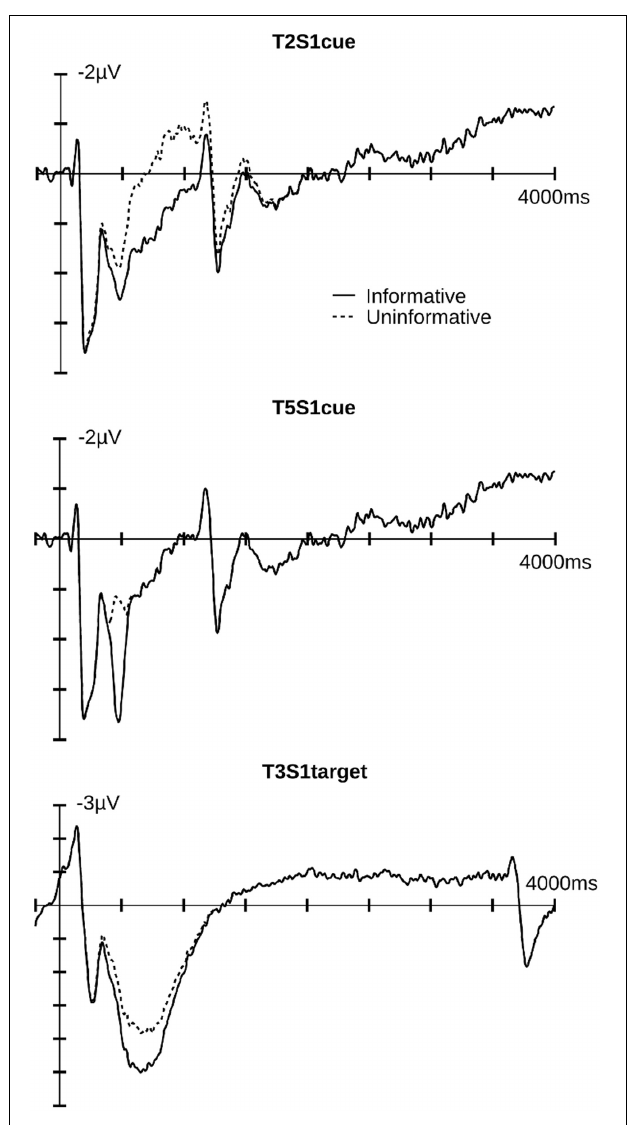
FIGURE 4 | Illustrated are the component traces for informative and uninformative cue conditions for both cue and target epochs. T2S1cue and T5S1cue components peaked at 754 and 473 ms after cue onset, respectively. T3S1target component peaked at 833 ms after target onset. Additional time course information is available in the Supplementary